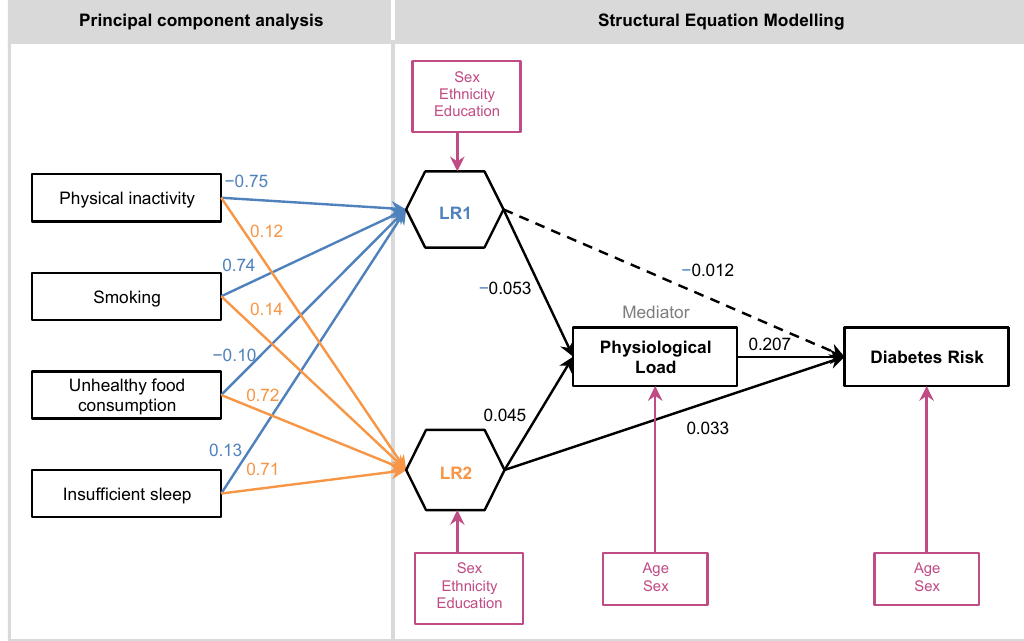
Figure 2. Model A: Factor loadings of the structural equation model (SEM) and the two principal components of Lifestyle Risk (LR1, LR2). Physiological Load was demonstrated to be a mediator of Lifestyle Risk to Diabetes Risk. There was also a significant direct path from Lifestyle Risk (LR2) to Diabetes Risk. Only statistically significant sociodemographic covariates (pink boxes) were included in the figure. Note: A straight line with one arrowhead denotes a significant effect; a dashed line with one arrowhead denotes an insignificant effect. Boxes indicate observed variables; hexagons indicate composite variables. Principal Component Aanalysis (PCA) loadings were rounded to 2 decimal places; Pathway loadings in SEM model were rounded to 3 decimal places.